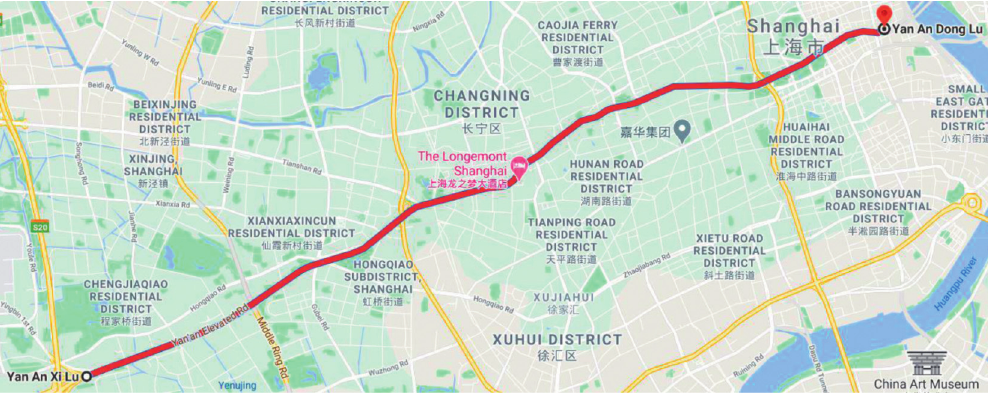
Figure 1: Yan’an elevated expressway, Shanghai,